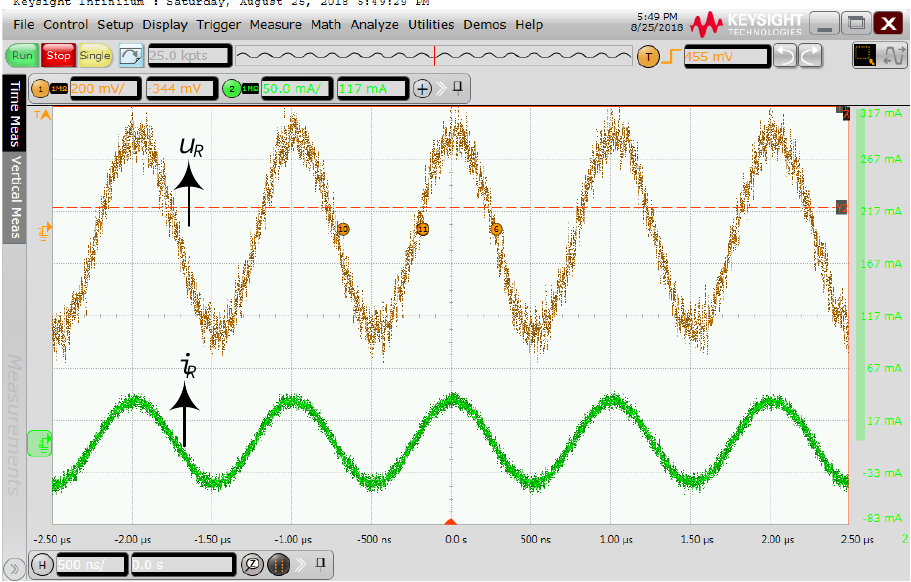
Figure 14. Experimental waveforms of